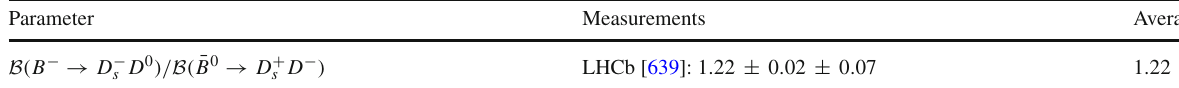
Table 155 Relative decay rates Parameter